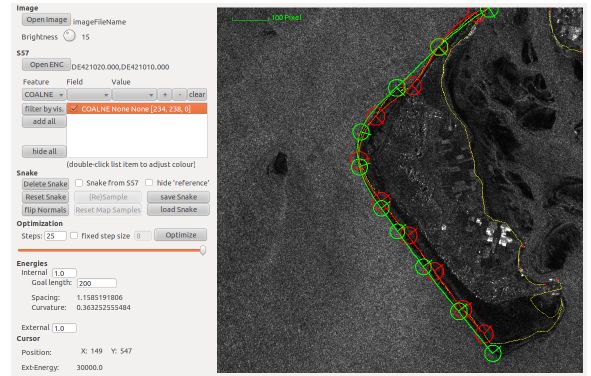
Figure 3: Overview of the current framework with controls on the left and an interactive view (showing the island of Amrum) on the right. After the optimization of the initial snake (red), all optimization steps can be visualized using a slider